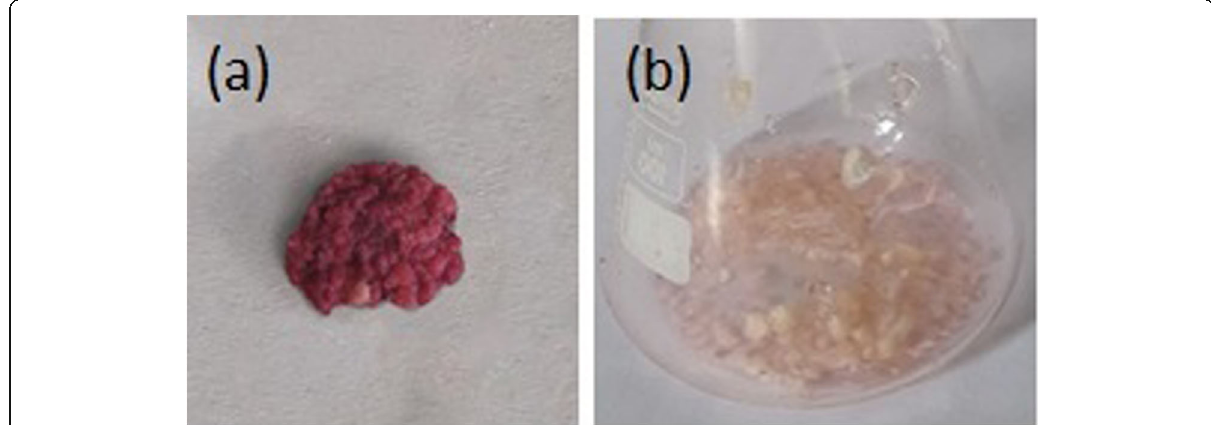
Fig. 3 Cell viability of G. walla ( a ) calli and ( b ) cell suspension after the TTC reduction